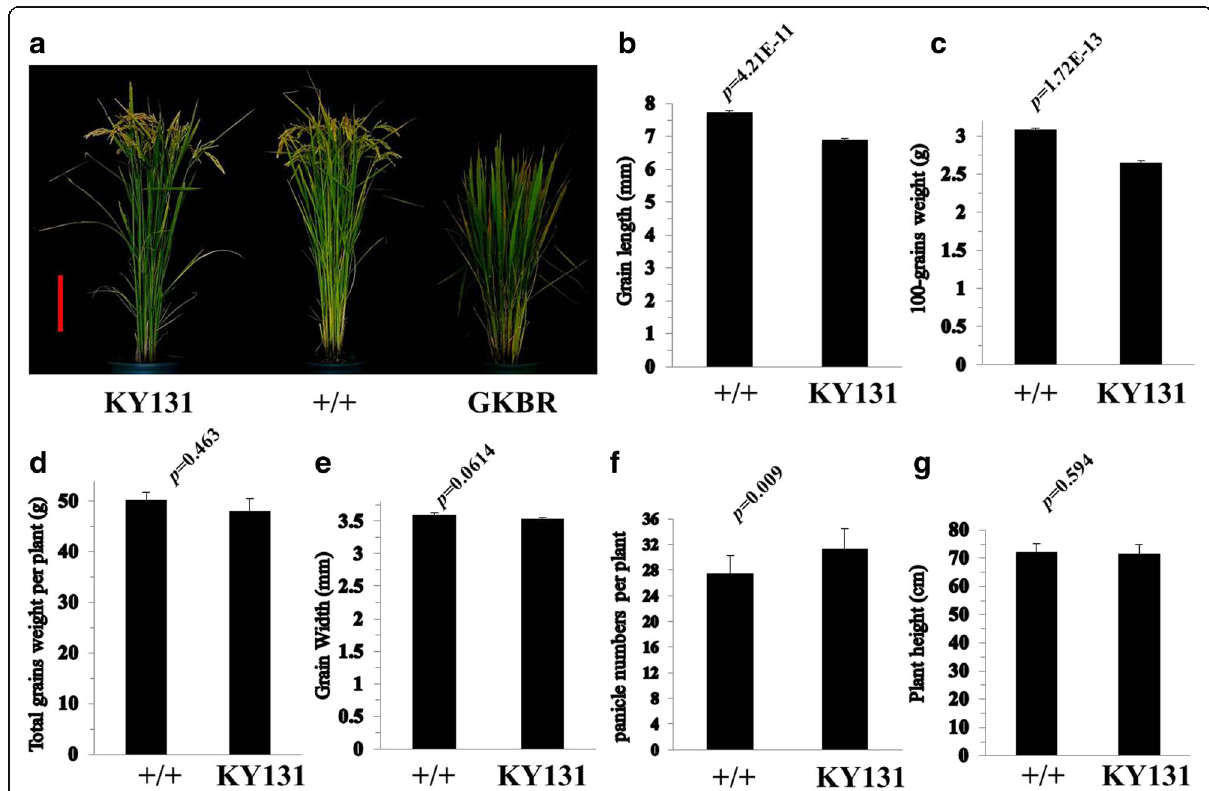
Fig. 4 Grain length and 100-grain weight significantly increased of the improved line compared with Kongyu 131. a Plant type of recurrent parent Kongyu 131, the improved line and the donor GKBR. Scale bar, 30 cm. b - g Comparison of yield-related traits of Kongyu 131 and the improved line. For b-g: n =10. The value in b-g represent the mean±s.d. p values from the student ’ s t -test of the improved line against Kongyu131 is indicated. KY131